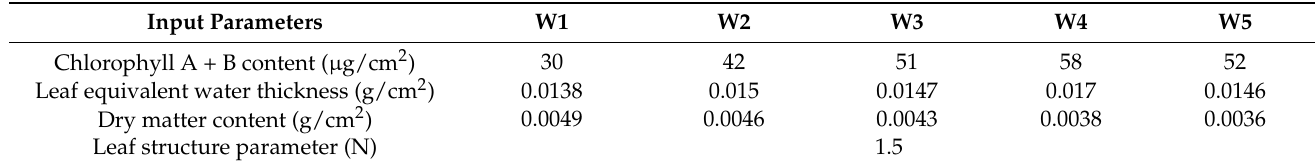
Table 2. Input parameters to the Prospect model for simulating leaf